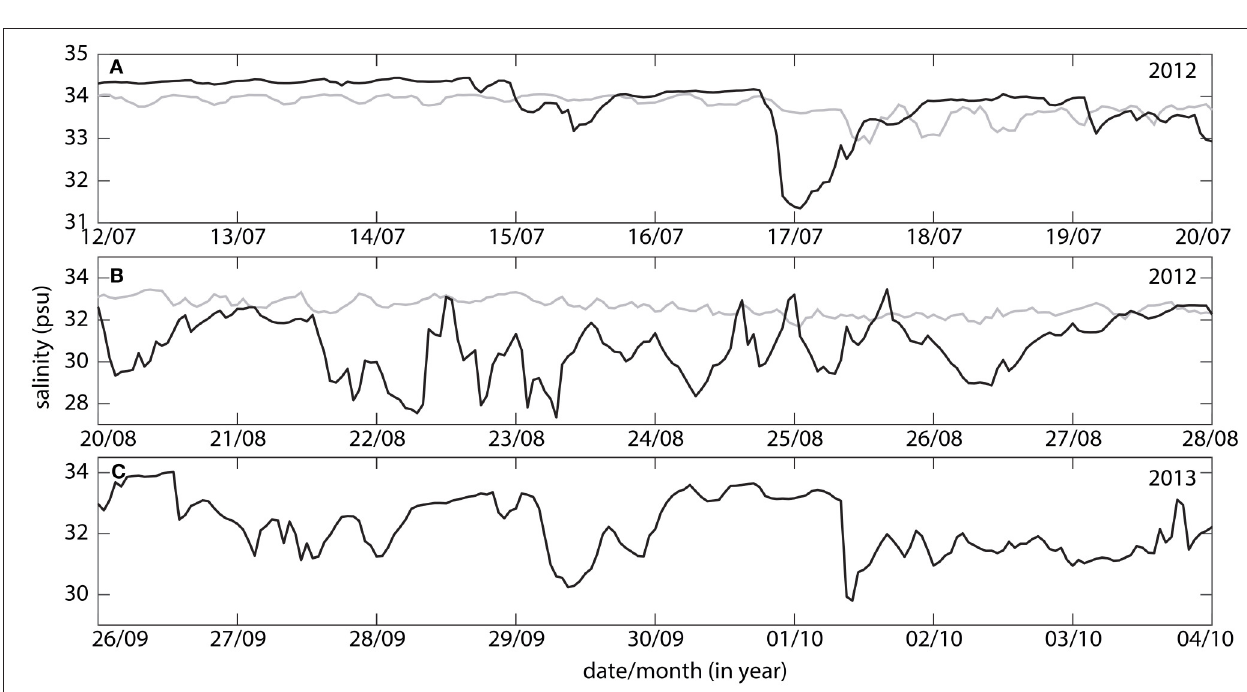
FIGURE 5 | Surface salinity for 8 days during (A) July 2012, (B) August 2012, and (C) October 2013 at WilsonB (black line) and Waiheke (gray line). Arrows in Figure 2 show the timing of the three events. Note that a mooring was not redeployed at Waiheke during October